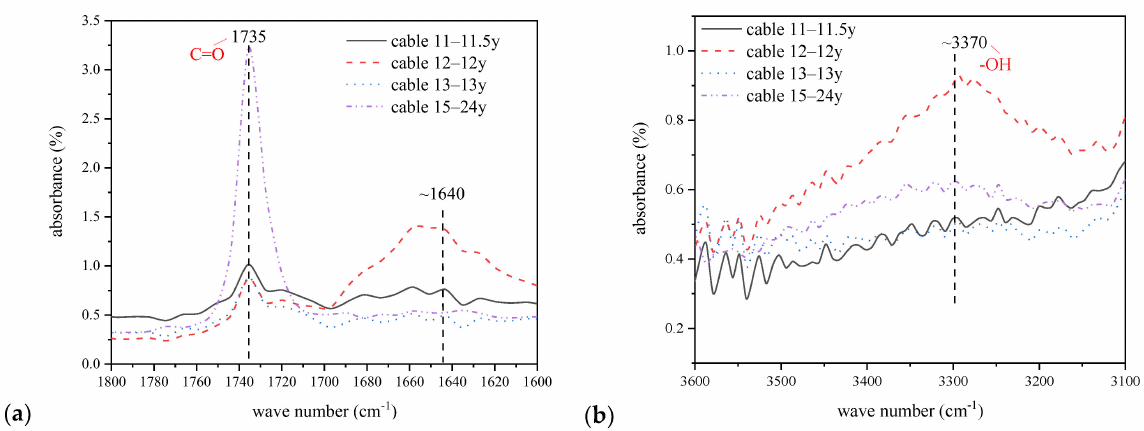
Figure 6. Detailed FTIR spectrum. ( a ) 1600–1800 cm − 1 ; ( b ) 3100–3600 cm − 1